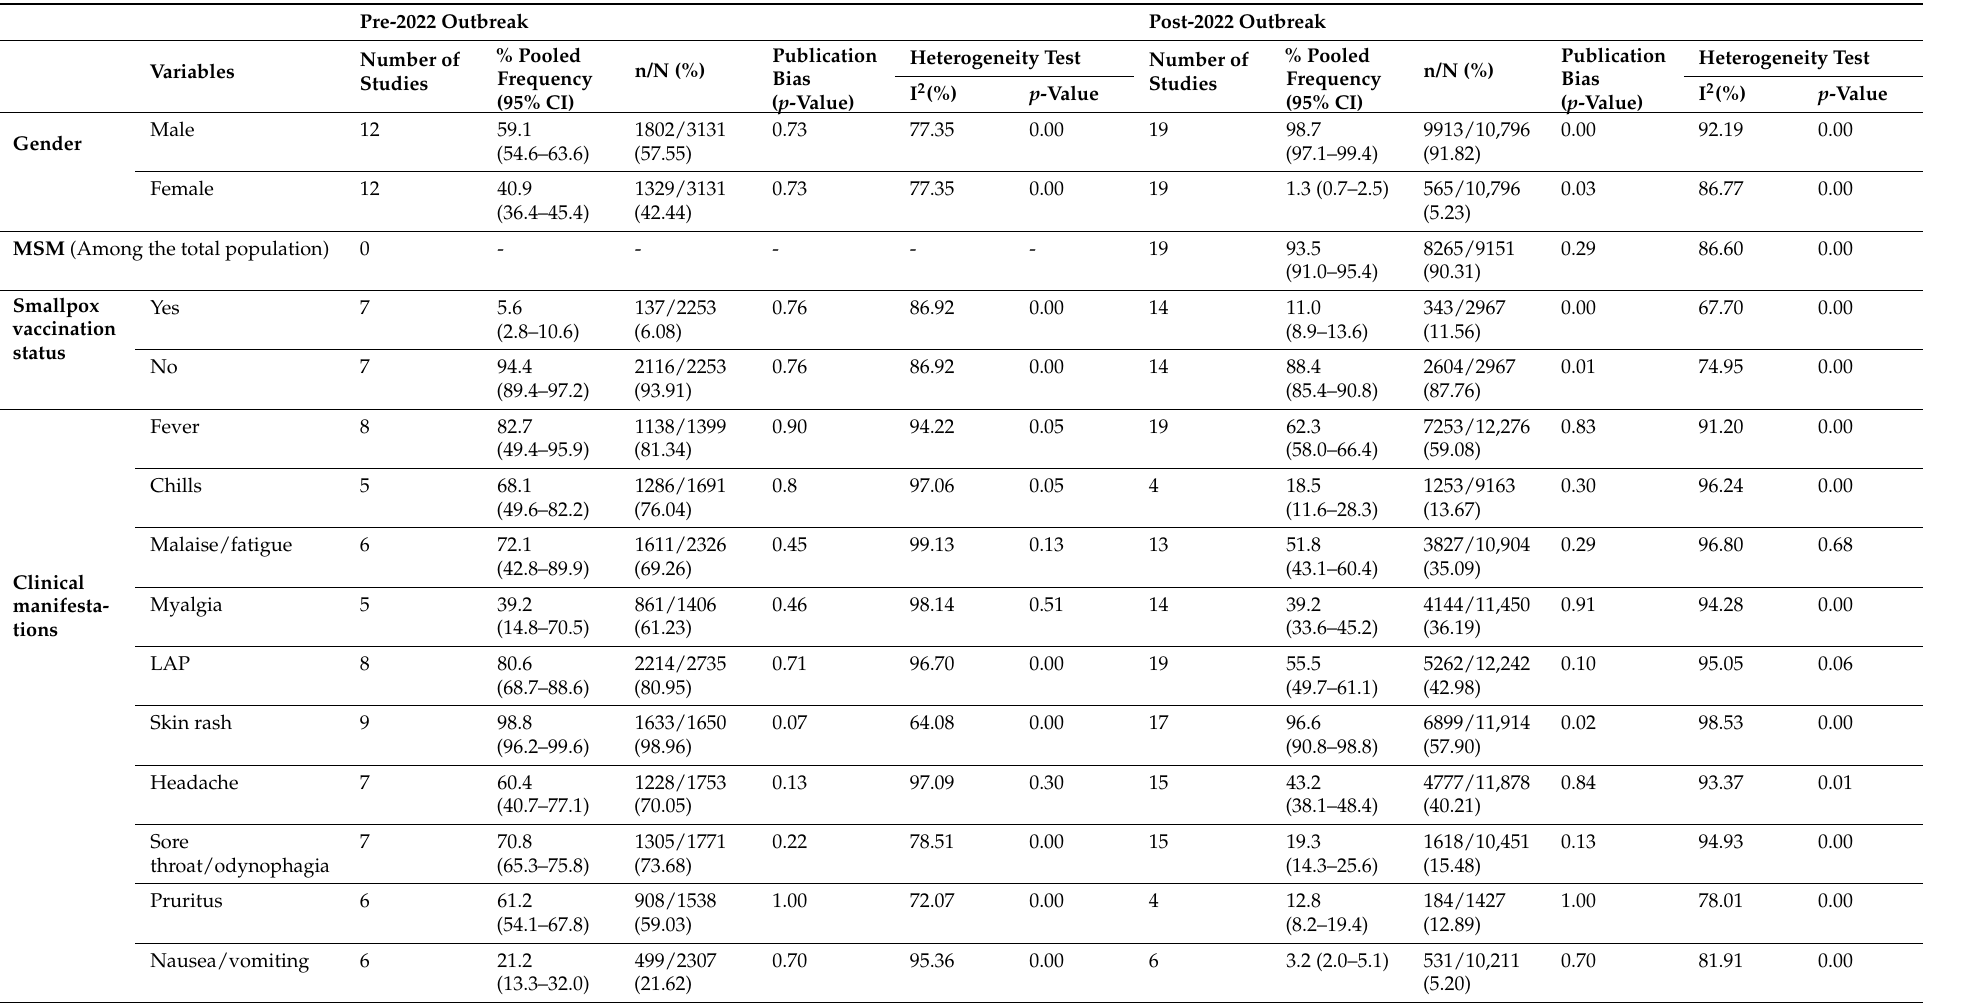
Table 6. Pooled frequency of the confirmed mpox patient